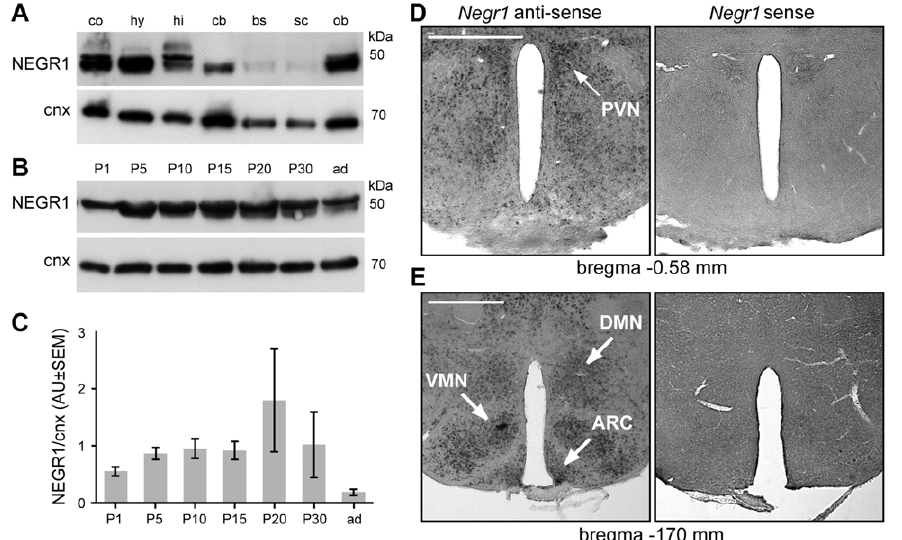
Figure 8. Expression of NEGR1. A. NEGR1 protein expression in different CNS regions from adult mice. B. Developmental expression regulation of NEGR1 in the postnatal hypothalamus. Blots were probed with antibodies specific to NEGR1 and ubiquitously expressed calnexin (cnx). C. Semiquantitative assessment of hypothalamic NEGR1 protein expression relative to cnx during postnatal development. D–E. Distribution of Negr1 mRNA in the adult murine hypothalamus in reference to bregma (n=4 mice/condition). Scale bars: 500 m m (D–E); ad: adult; co: cerebral cortex; hy: hypothalamus; hi: hippocampus; cb: cerebellum; bs: brainstem; sc: spinal cord; ob: olfactory bulb; cnx: calnexin; PVN: paraventricular nucleus; DMN: dorsomedial nucleus; VMN: ventromedial nucleus; ARC: arcuate